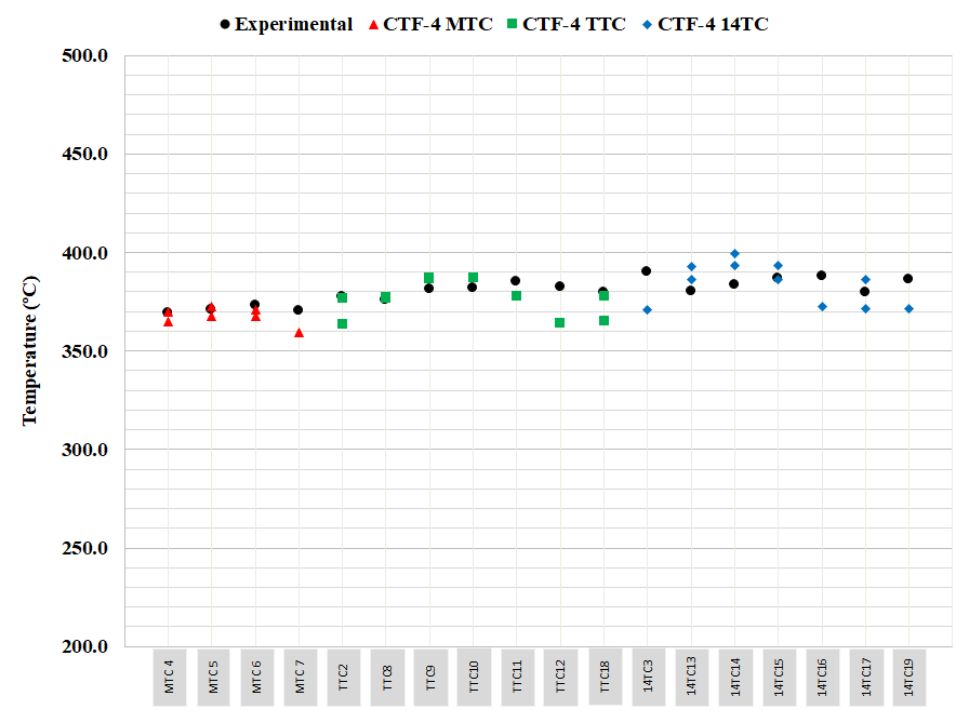
Figure 5. SHRT-45 steady state temperature predictions for XX10